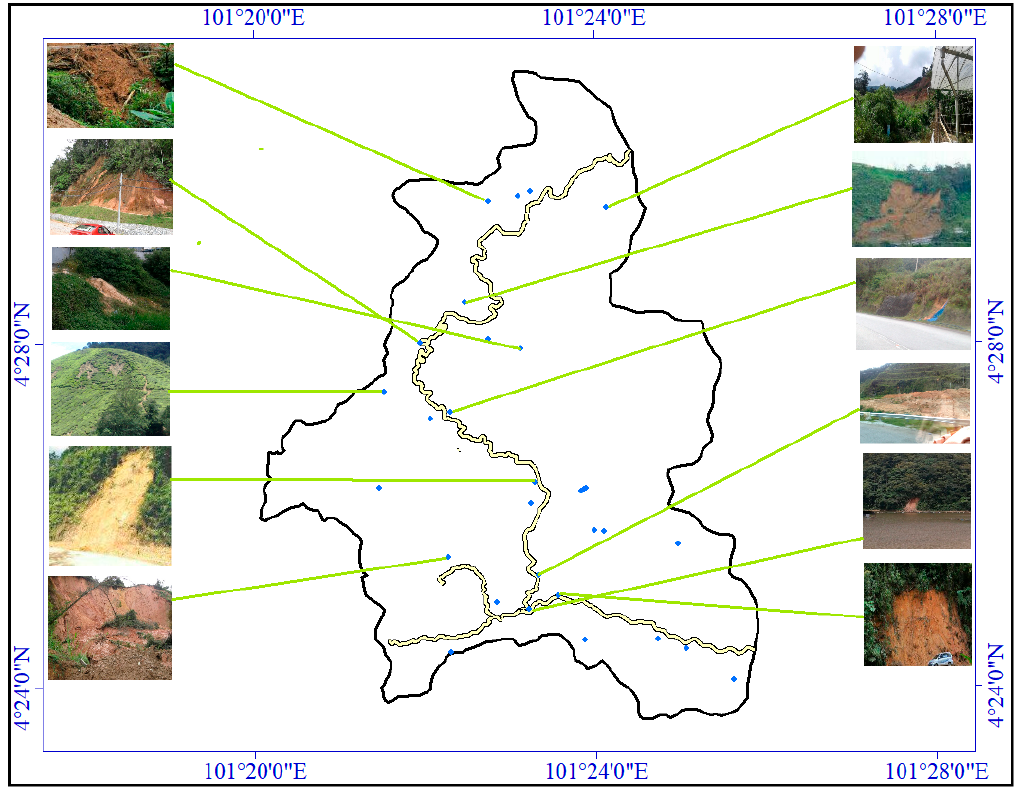
Figure 8. Validated landslide locations using a handheld